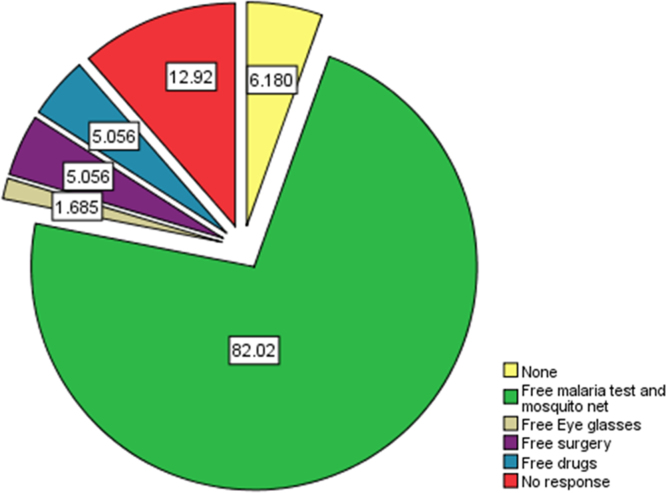
Summary of freely accessible government health care schemes available to citizens.